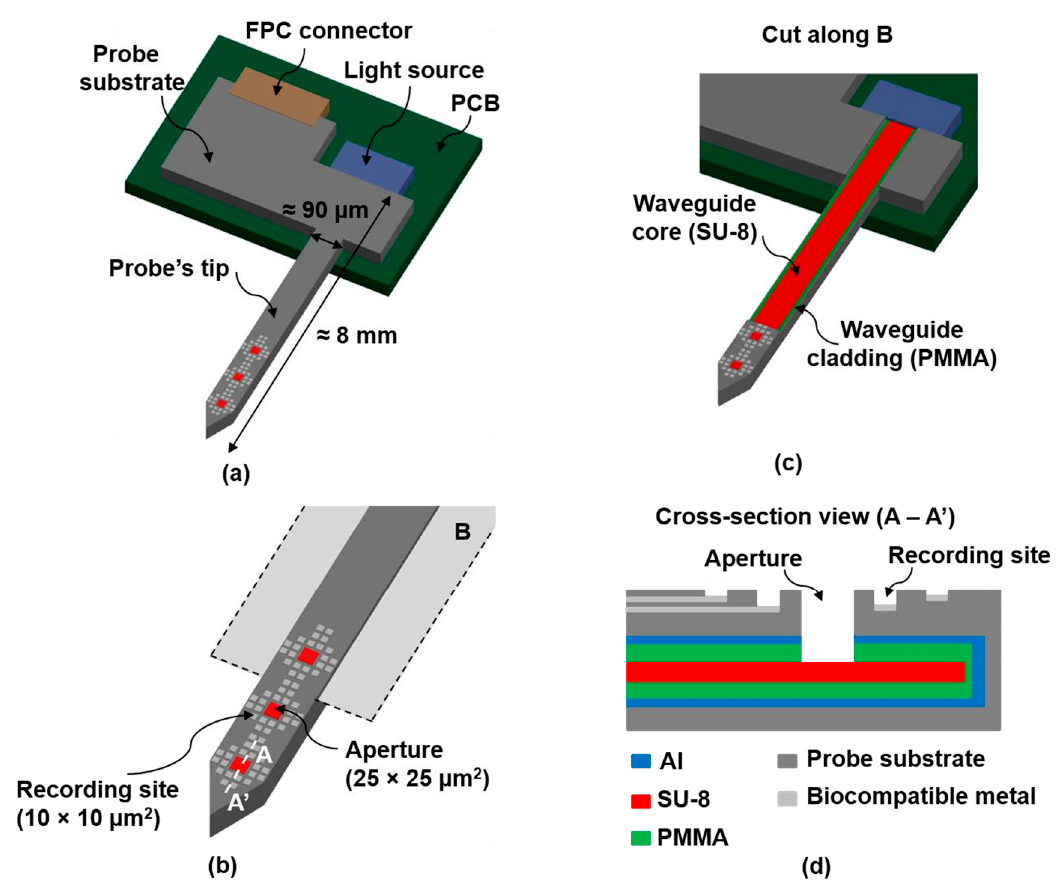
Figure 1. ( a ) Overall schematic of the final optrode; ( b ) Zoomed figure showing the probe’s tip with several recording sites and 3 apertures or light outputs; ( c ) Cut along B (as indicated on ( b )), showing the SU-8 based waveguide; ( d ) Cross-section view (A − A’), as indicated on ( b ).